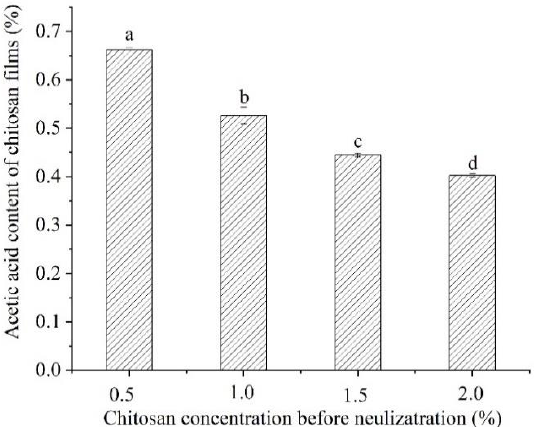
Figure 3. Effects of chitosan concentration on acetic acid contents of chitosan films before neutraliza- tion. Different letters indicate significant differences ( p <0.05).